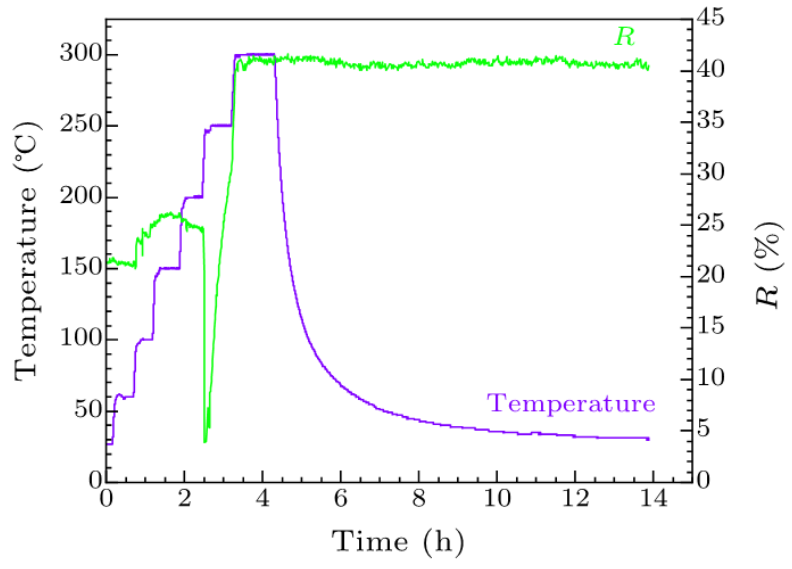
Figure 5. The substrate reflectivity and temperature during the heating removal process of K-Cs-Sb photocathode [57].